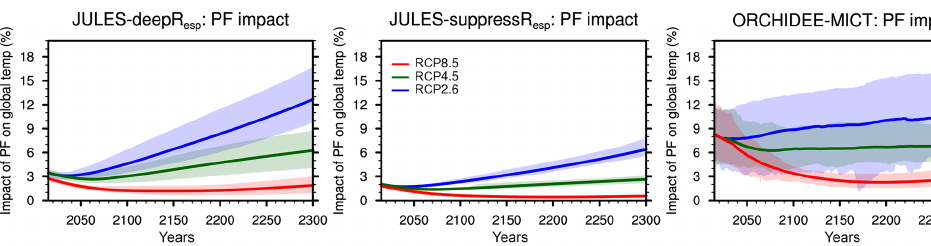
independent of scenario, but there are some notable differ- ences between the different model